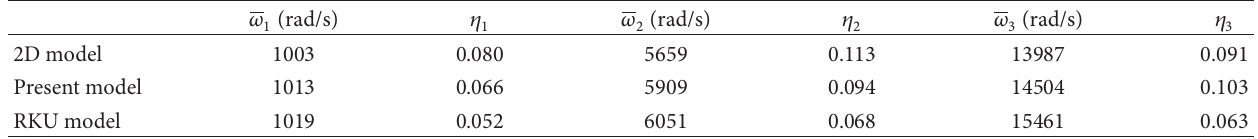
Table 3: Modal properties of the sandwich cantilever beam with 𝐻 2 = 5 mm.